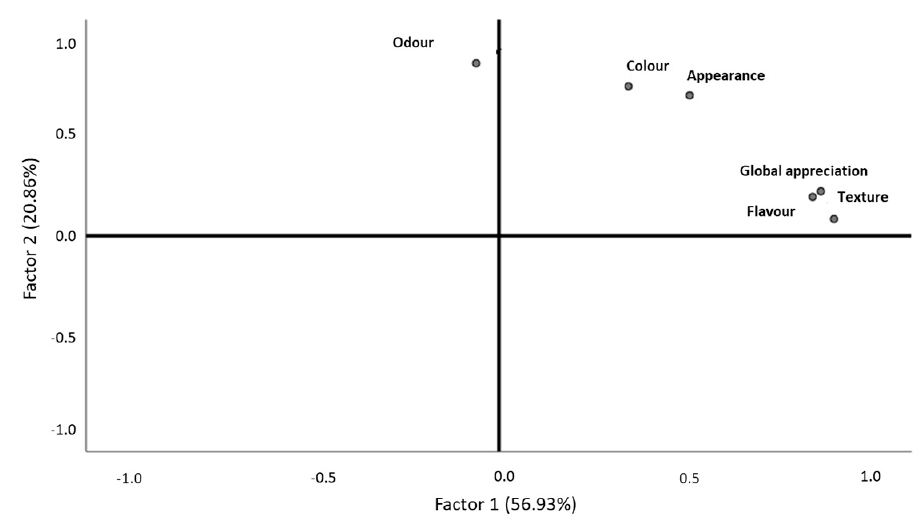
Figure 5. Behavior of dehydrated piper gurnard descriptors, according to consumer classifications. Table 6. Rotated component matrix for each dehydrated piper gurnard descriptor.